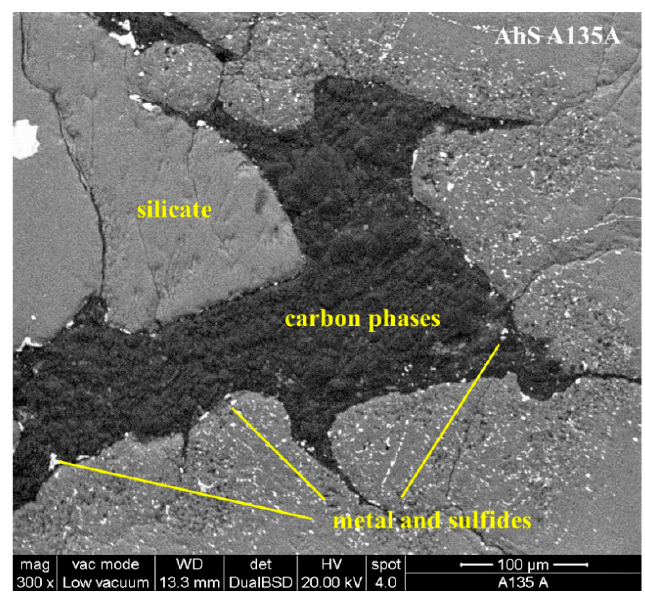
Figure 5. Carbon area in AhS A135A. Back-scattered electron image (BSE) of the non-carbon-coated surface of AhS A135A collected in low-vacuum mode.